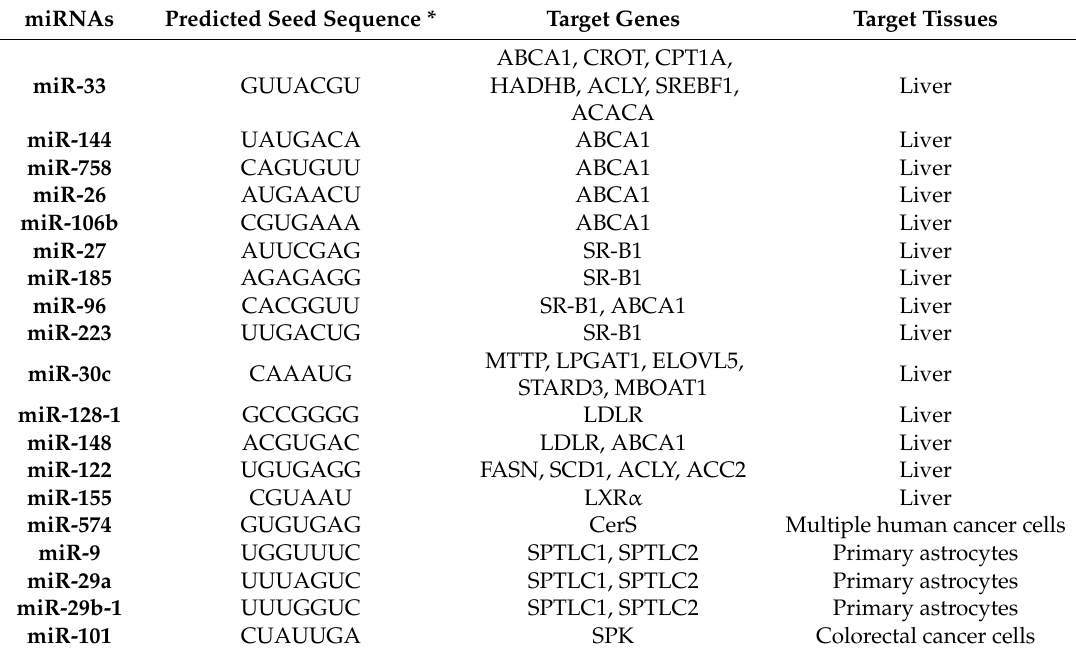
Table 1. Predicted seed sequence, target genes and tissues of miRNAs implicated in lipid and sphingolipid